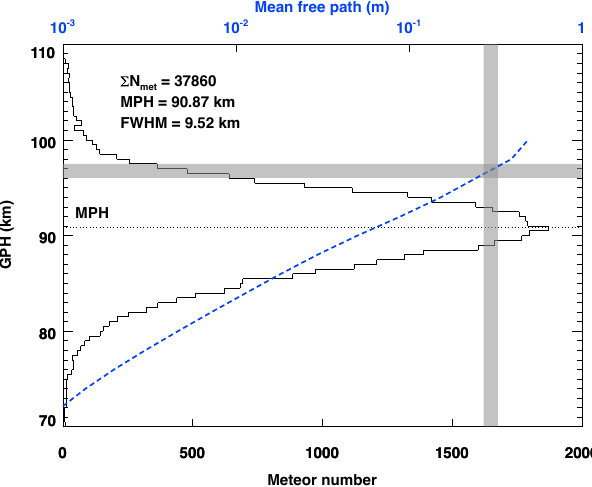
Figure 4. (a) The height variation of the three yearly mean attenu- ation coefficients and their 1 standard deviation values (color-filled horizontal bars) calculated from the KSS meteor radar observations in 2014, and (b) the normalized percentage of yearly mean total attenuation coefficients in 2014–2016.